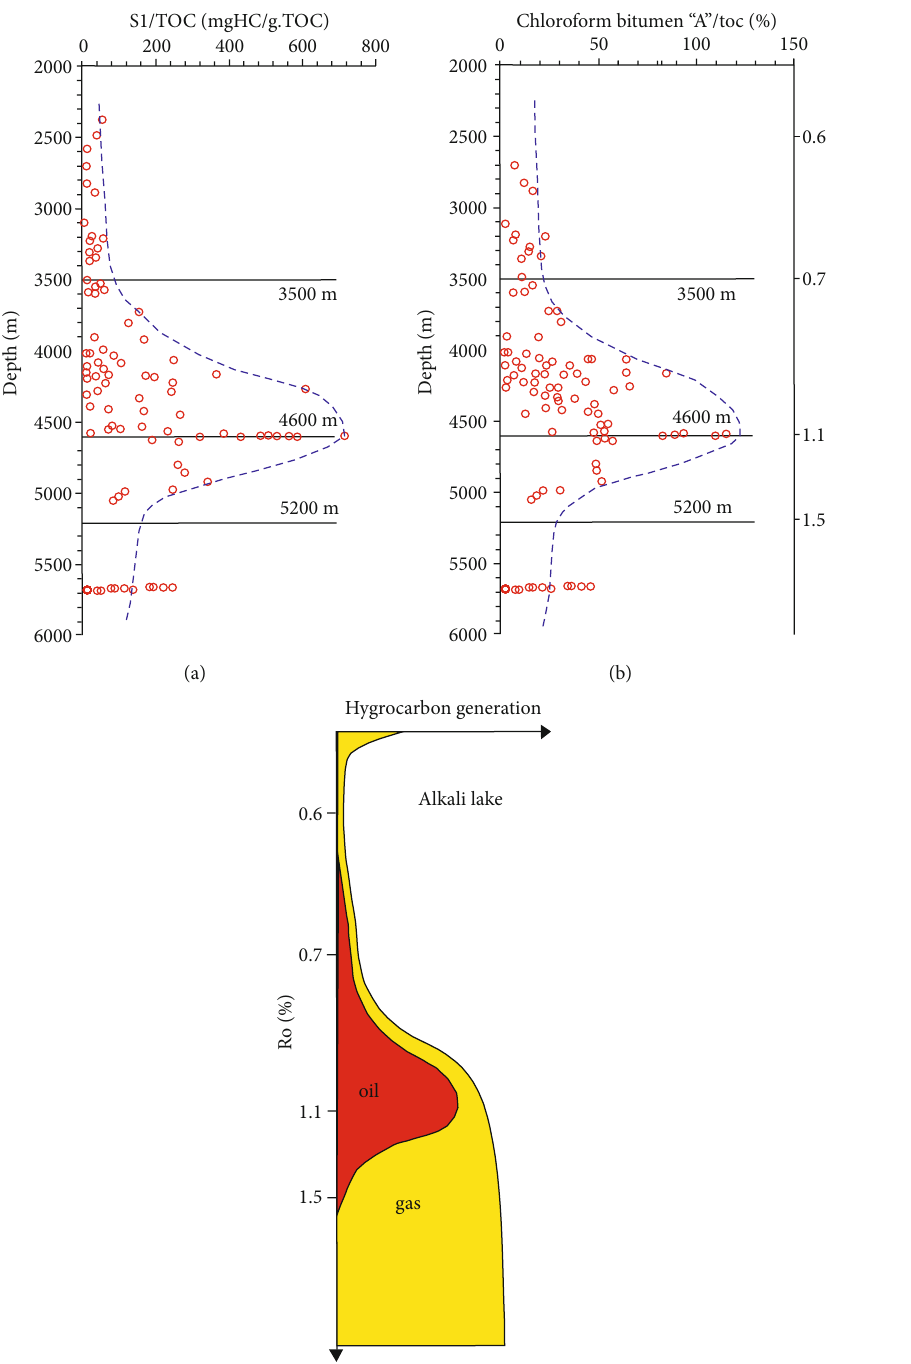
with depth and R . (b) Main stage of oil generation according to variations in 1 /TOC O . (c) Hydrocarbon generation model for source rocks O